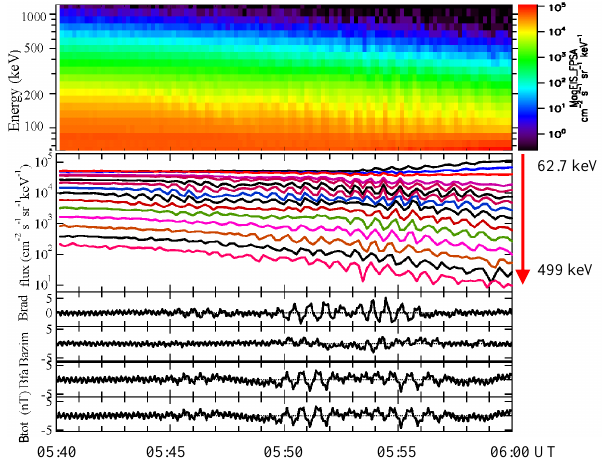
Figure 6. Energetic particle observations from the Van Allen Probe B MagEIS instrument and magnetic field from the EMFISIS in- strument in field-aligned coordinates from 05:40 to 06:00UT. The upper and middle panels show proton energy spectra in the range of energies from 50keV to 1.0MeV and the spin-averaged fluxes in the range of energies from 62.7 to 500keV. The bottom panel presents the radial, azimuthal and field-aligned components, and to- tal magnetic field